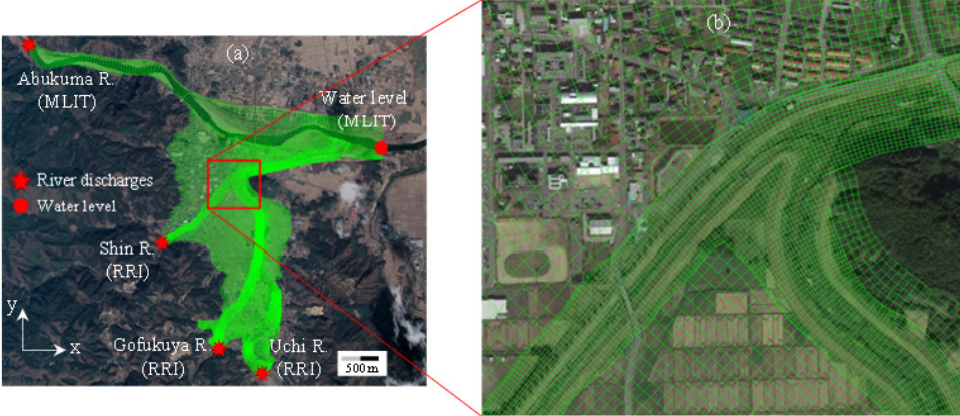
Figure 5. Environmental Fluid Dynamics Code Plus (EFDC+) model grid configuration and loca- Figure 5. ( a ) EFDC+ model configuration and boundary condition locations, ( b ) Closer-view of tions of boundary condition. model grid